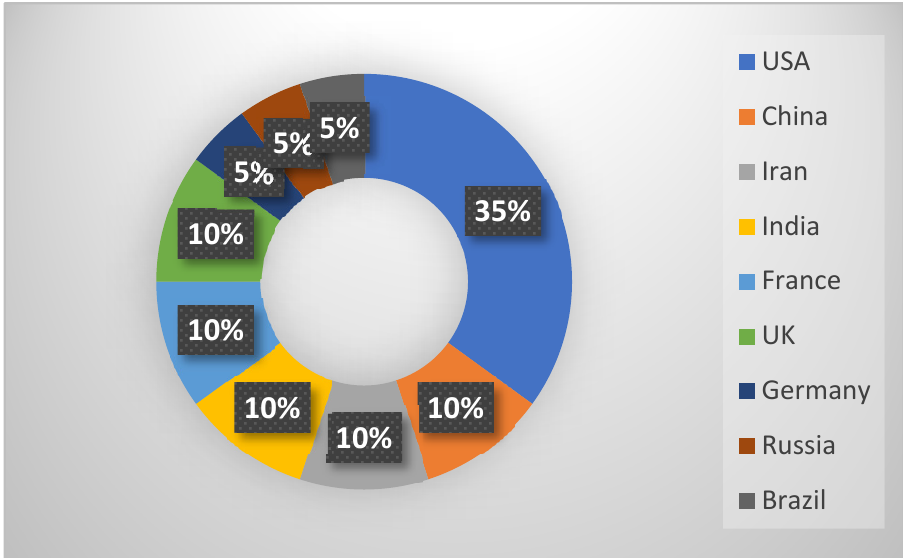
Figure 6. Total number of institutions/organizations belonging to a specific country based on the top